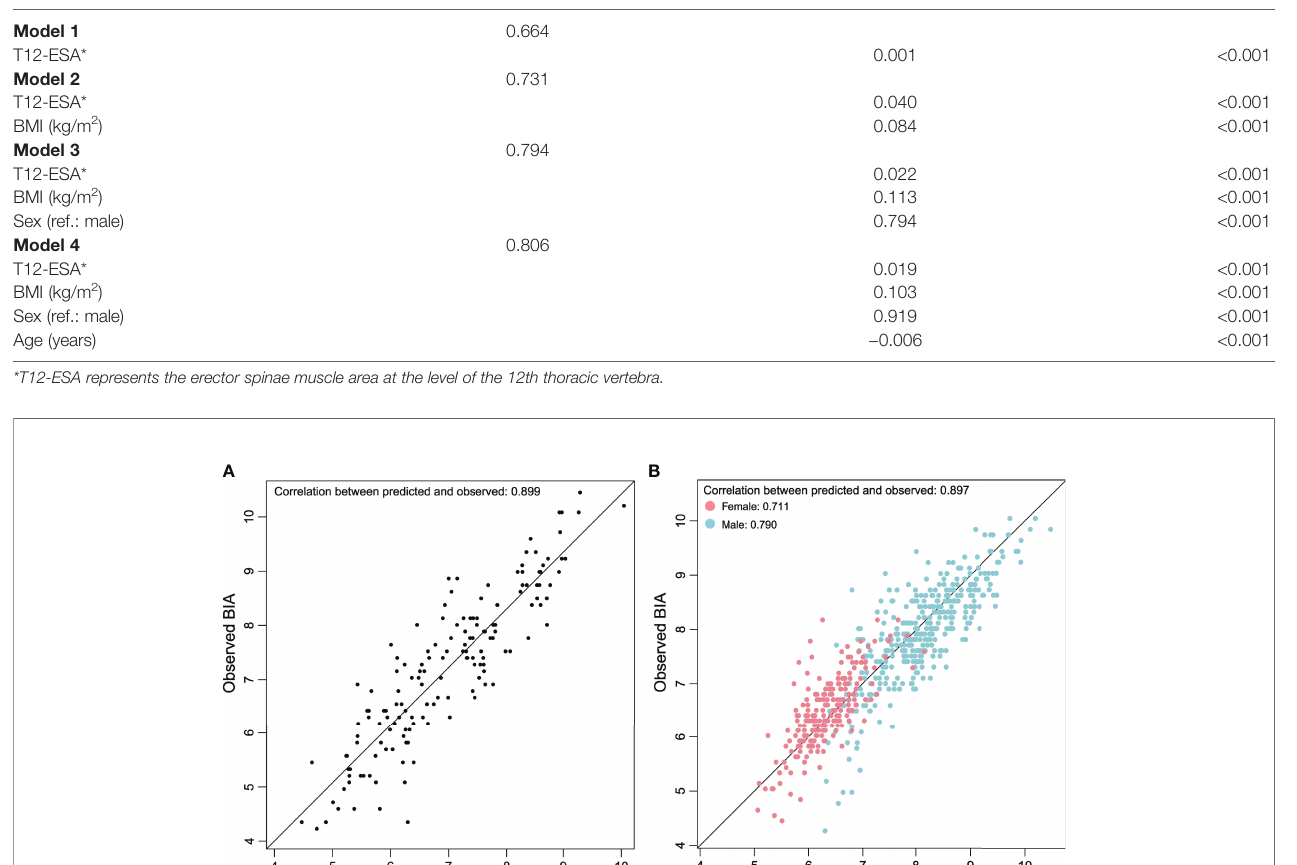
TABLE 2 | Stepwise model building in the training group to generate an equation to convert T12-ESA to BIA. Independent variable